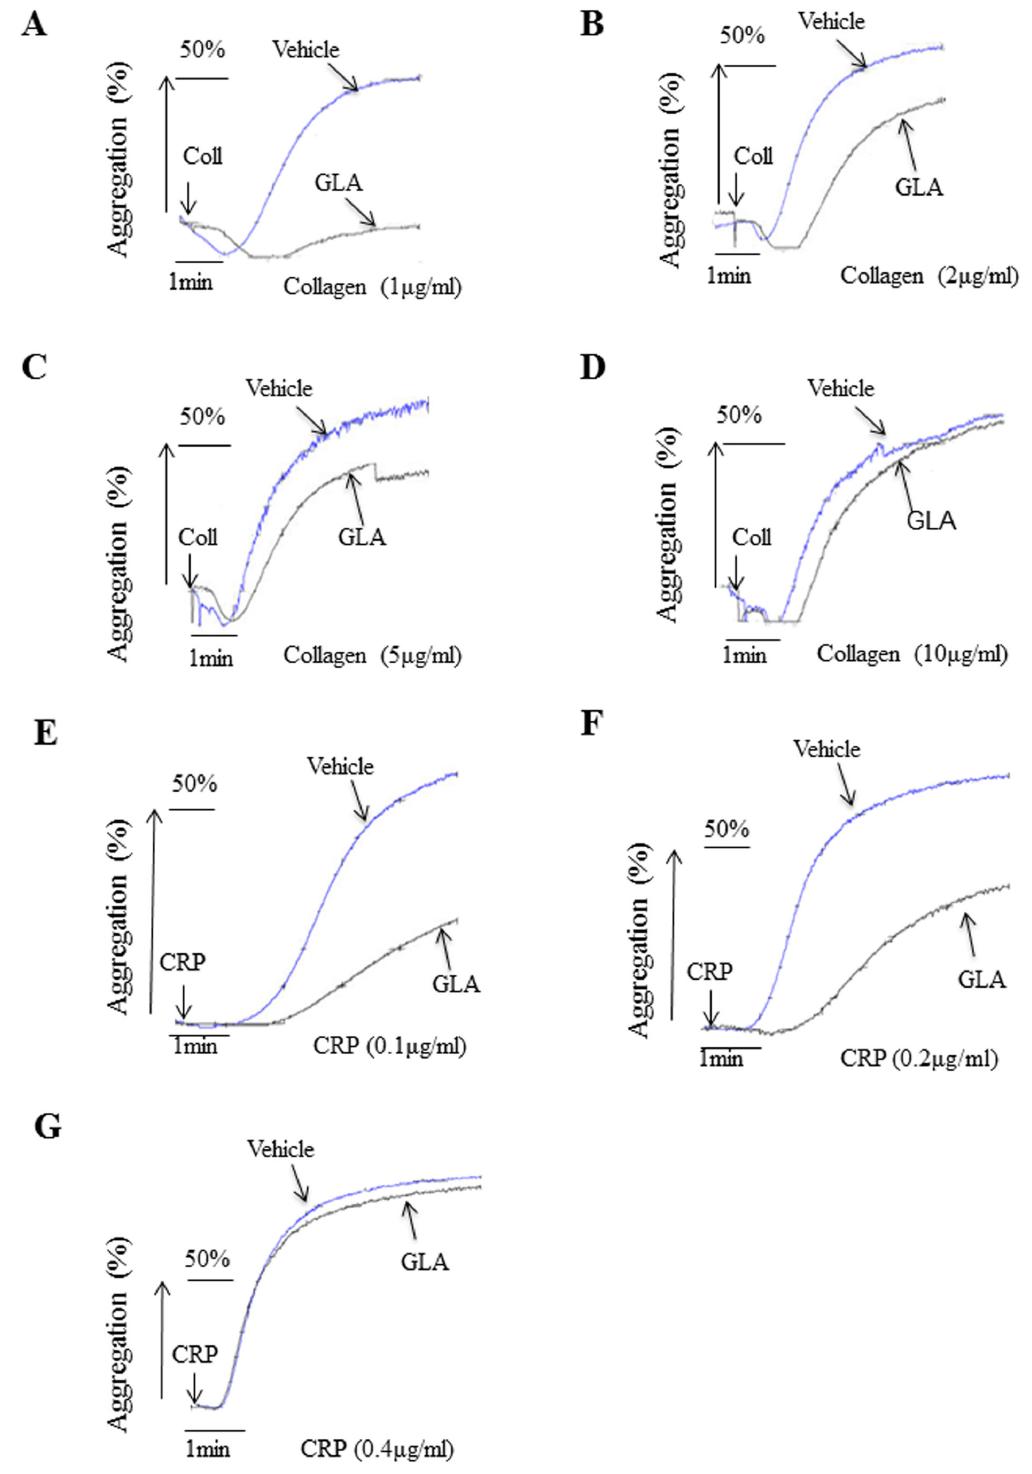
Figure 3. Effects of GLA on platelet aggregation induced by different concentration of collagen and CRP. Gel-filtered platelets (2.5×10 8 /ml) were pre-incubated for 10 min with GLA (0.01μg / mL) or vehicle (DMSO). Platelet aggregation was initiated with 1μg/ml (A), 2μg/ml (B), 5μg/ml (C), and 10μg/ml (D) of collagen, and 0.1μg/ml (E), 0.2μg/ml (F), and 0.4μg/ml of CRP (G). The aggregation curves are the representatives of at least three individual experiments. doi: 10.1371/journal.pone.0085120.g003 PLOS ONE |